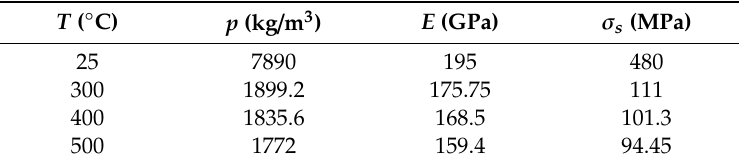
Table 3. Physical properties of 316 L in di ff erent temperature.